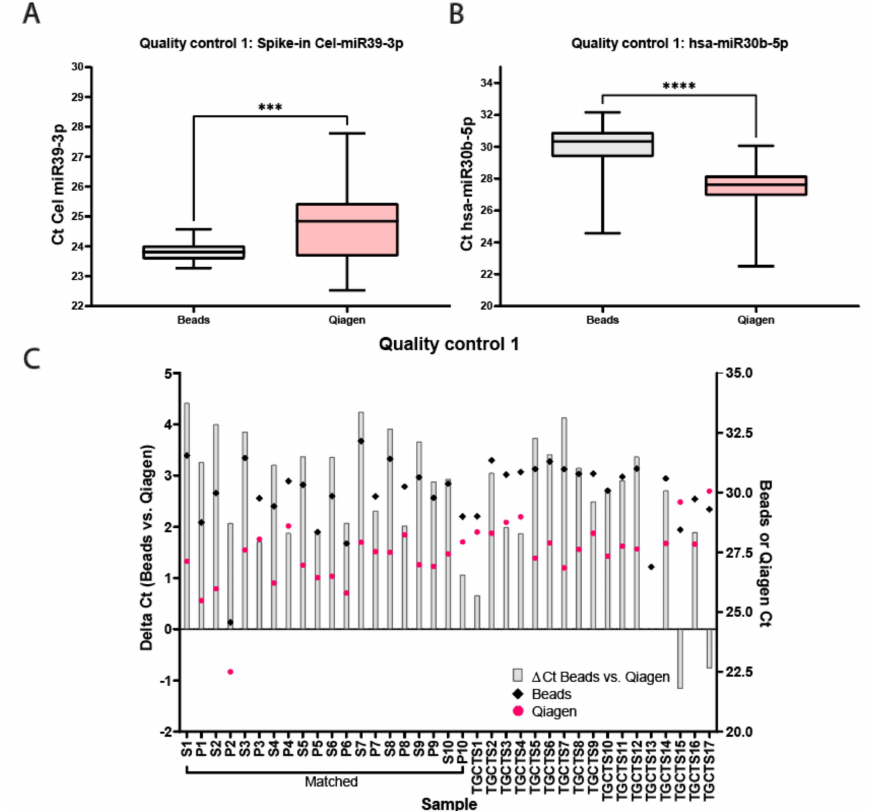
Figure 2. Quality control for bead-capture and Qiagen kit isolation. ( A ) Cts for Cel-miR39-3p spike-in quality control isolated with beads (black) or Qiagen (pink). Average Ct Beads: 23.81 ± 0.33, Average Ct Qiagen 24.68 ± 1.32, *** p < 0.005. ( B ) Cts for hsa-miR30b-5p endogenous quality control isolated with beads (black) or Qiagen (pink). Average Ct Beads: 29.98 ± 1.45, Average Ct Qiagen 27.45 ± 1.30, **** p < 0.0001. ( C ) Delta Cts of hsa-miR30b-5p between the bead-capture and Qiagen kit isolation (grey bars). Raw Cts obtained with the bead (black) of Qiagen (pink) isolation protocol are plotted on the right y